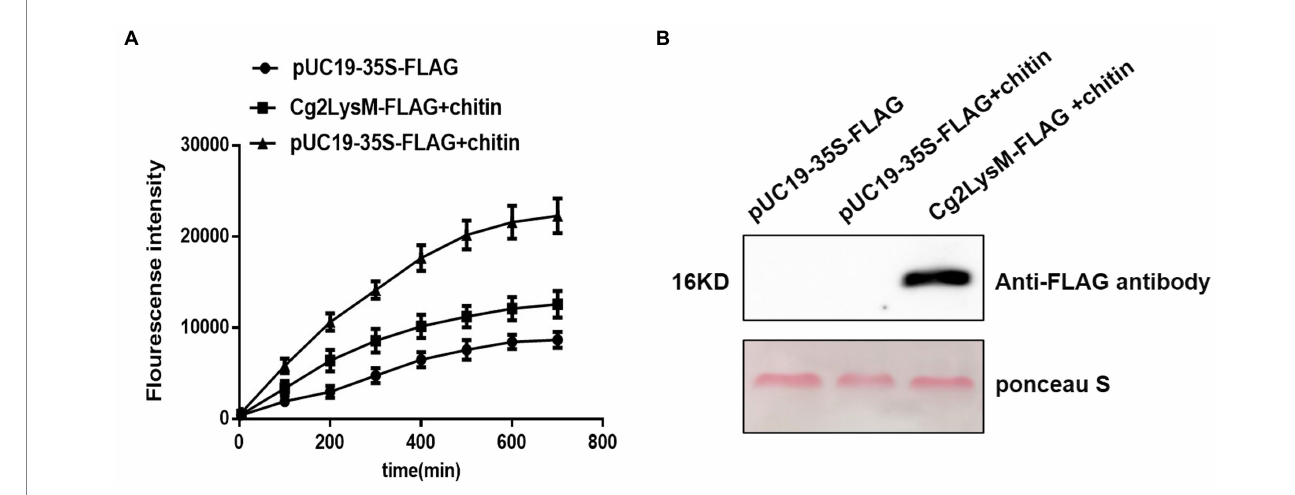
FIGURE 6 Effector of Cg2LysM on the ROS production induced by chitin. (A) ROS assay in rubber tree mesophyll protoplasts expressing empty vector without/with chitin treatment and expressing Cg2LysM with chitin treatment. ROS contents was measured by DCFH-DA. (B) Expression assay of Cg2LysM in different samples. Expression level of Cg2LysM was detected by western